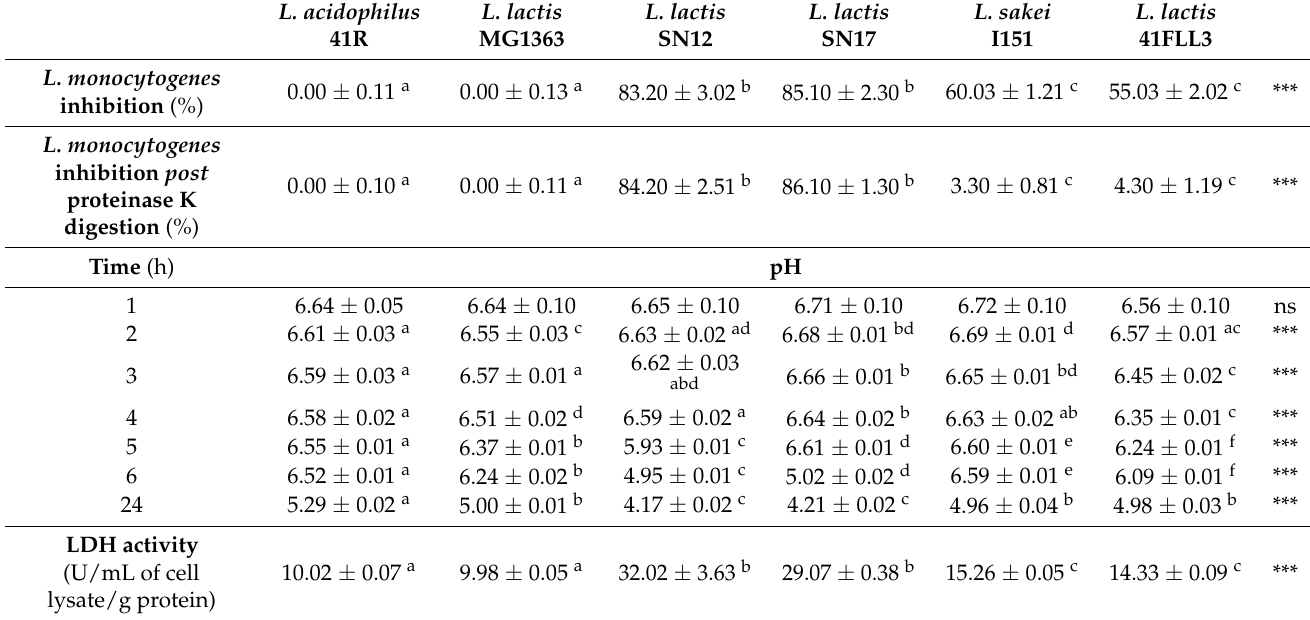
Table 1. Percentage of L. monocytogenes inhibition (pre- and post-proteinase K digestion), acidification profiles and LDH activity for the two control-strains not displaying antibacterial activity ( L. acidophilus 41R and L. lactis MG1363) and for the four strains ( L. lactis SN12, L. lactis SN17, L. sakei I151 and L. lactis 41FLL3) interfering with the growth of L. monocytogenes . Data represent means ± standard deviations (N = 3). Statistics: ANOVA p < 0.001 (***); p > 0.05 (ns). Tukey’s post hoc tests were performed and letters indicate significant differences between